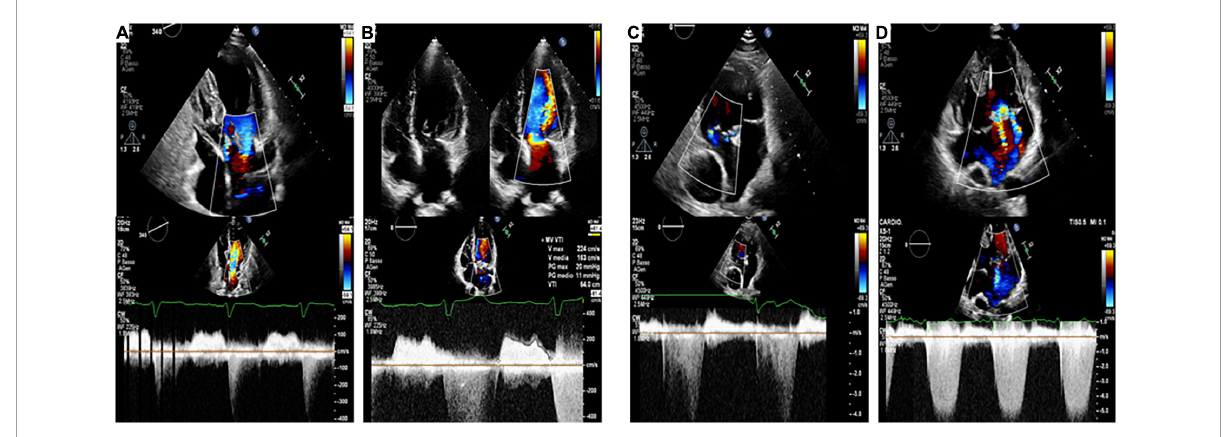
FIGURE4 Echocardiographic images (Top: apical 4-chamber views, Bottom: CW Doppler through mitral valve and systemic AV valve) of four patients included in our study, coupled according to the ACHD [ (A,B) : repaired partial atrioventricular septal defect; (C,D) : Fontan circulation], with (Panel B,D ) and without (Panel A,C ) associated S-VHD. This is illustrative of our findings, since patients (B–D) experienced hospitalization for heart failure. while patients (A–C) had an unremarkable clinical